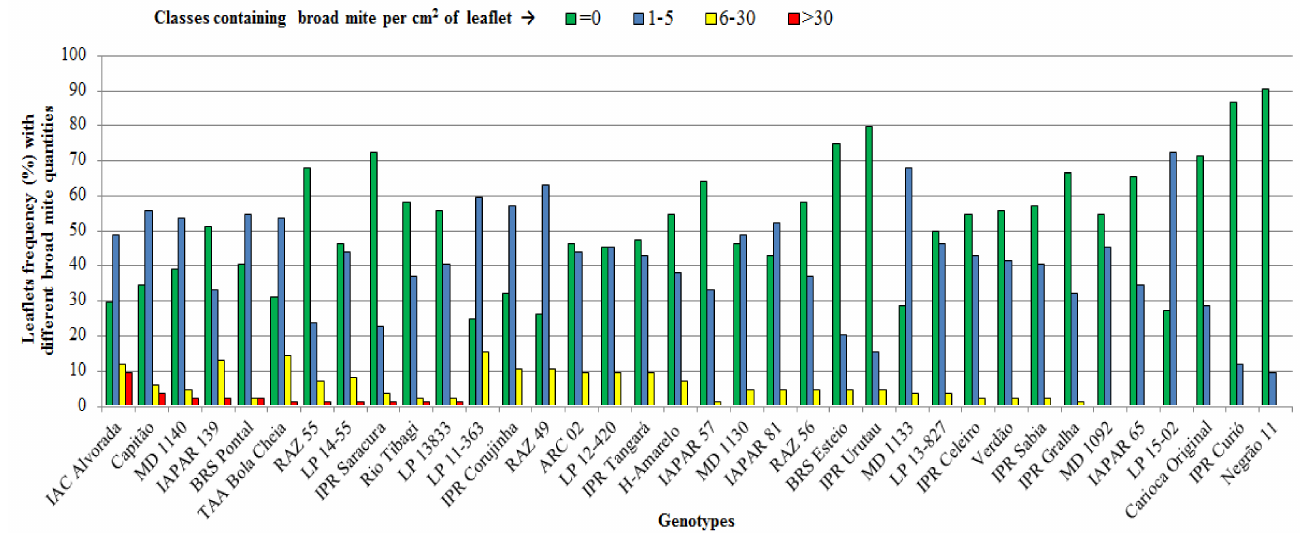
Figure 1. Frequency distribution of four classes of frequencies of broad mite in 1 cm 2 of leaflets in different common bean genotypes. Londrina-PR, 2020.